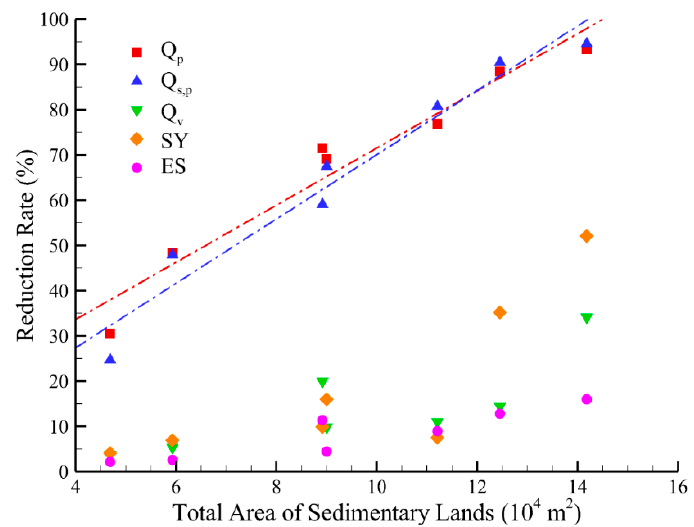
Figure 8. Relationship of the total area of sedimentary lands and reduction rate of flood processes and sediment transport processes.